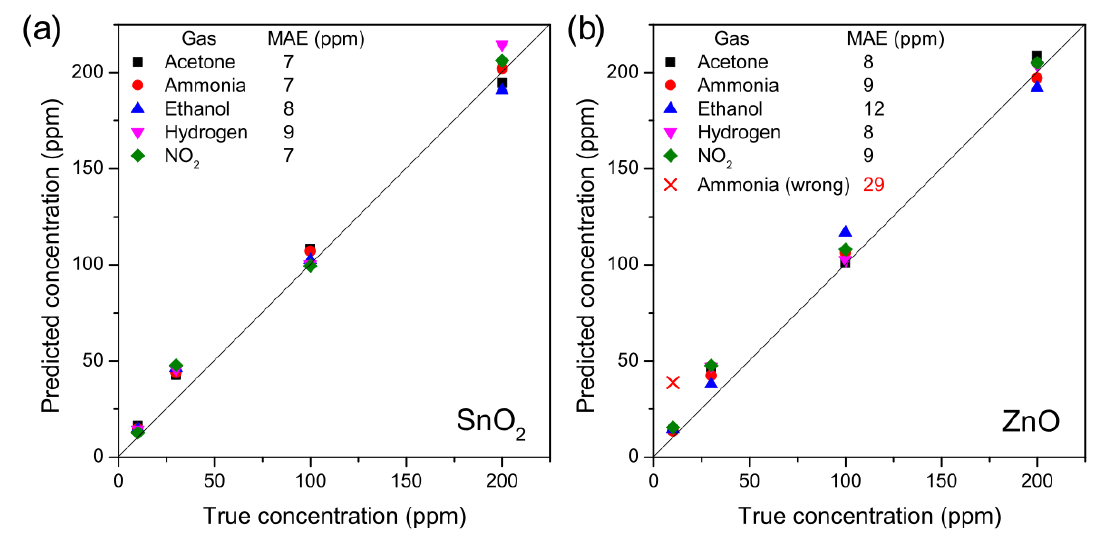
Figure 7. Predicted gas concentration as a function of the true concentration by the thermal electronic nose based on ( a ) SnO 2 nanowires and ( b ) ZnO nanowires.